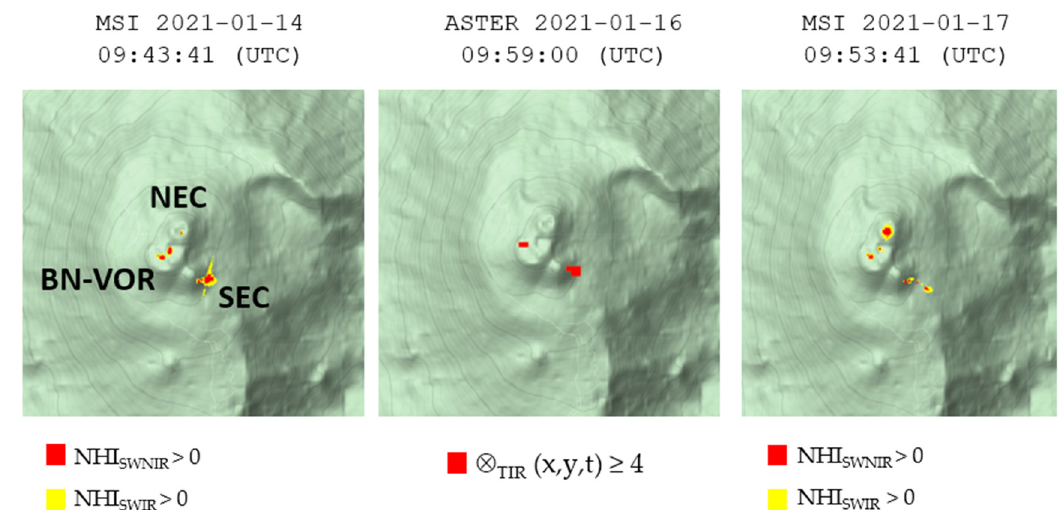
Figure 11. Mt. Etna activity detected by NHI through the indices NHI SWNIR and NHI SWIR (the latter is used to detect mid-low intensity hotspots [20]) on Sentinel-2/MSI data of 14 and 17 January 2021 (left and right panels) and by RASTer on ASTER scene of 16 January 2021 (middle panel).